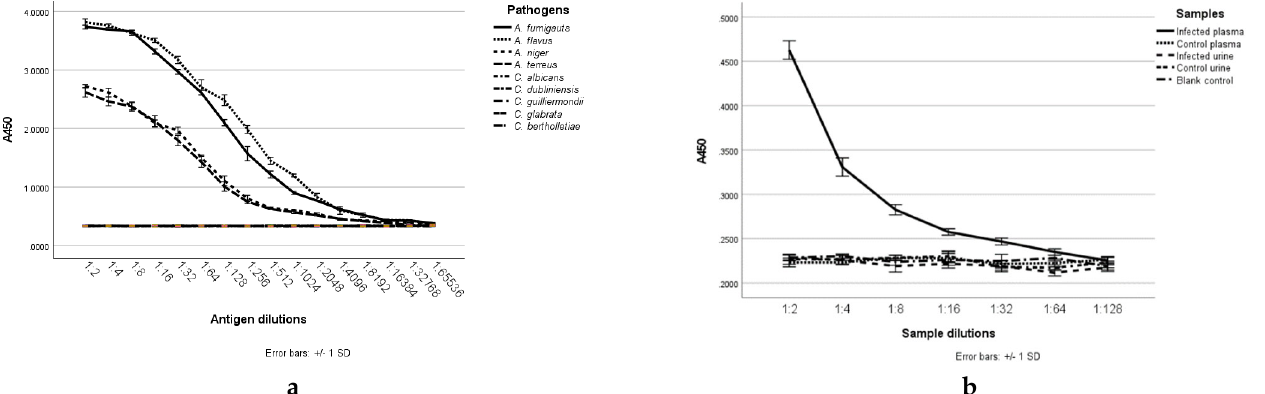
Figure 7. The double ‐ sandwich ELISA detects only Aspergillus fungal antigens in culture filtrate dilutions ( a ). It also detects circulating antigens in dilutions of plasma but not urine in mice with invasive aspergillosis ( b